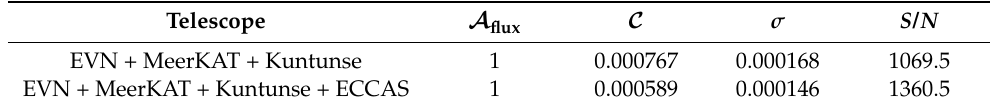
Table 1. Measured parameters used to calculate S / N .